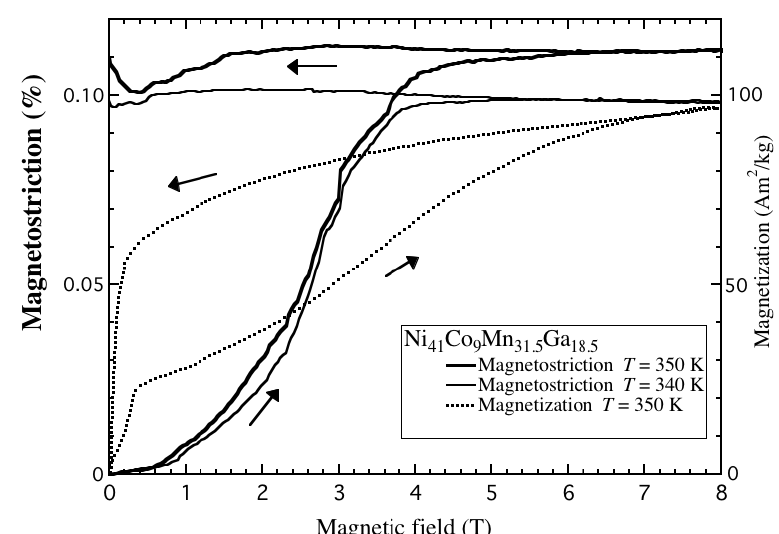
Co Mn Ga at the temperatures between T 41 9 31.5 18.5